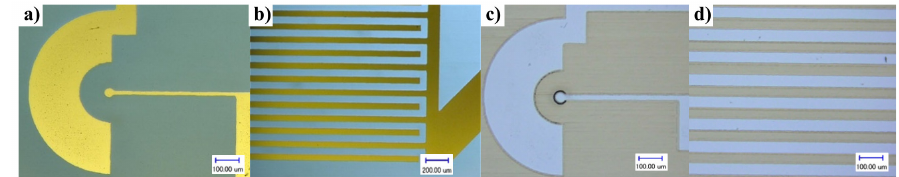
Figure 1. Platinum ( a , b ) and indium tin oxide (ITO) ( c , d ) structures of the oxygen sensors with a circular working electrode spot and semi-circular counter electrodes ( a , c ), as well as interdigitated electrode structures (IDES) with a50- μ m pitch ( b , d ). The on-chip-sensor connectors were insulated in a following processing